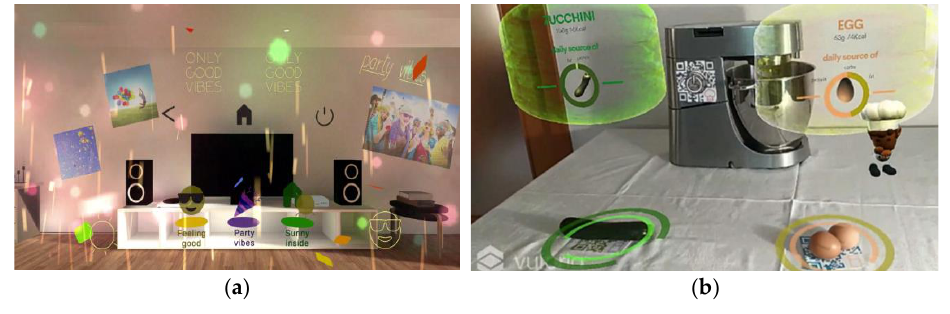
Figure 9. ( a ) Hi-Fi GUI; ( b ) kitchen robot